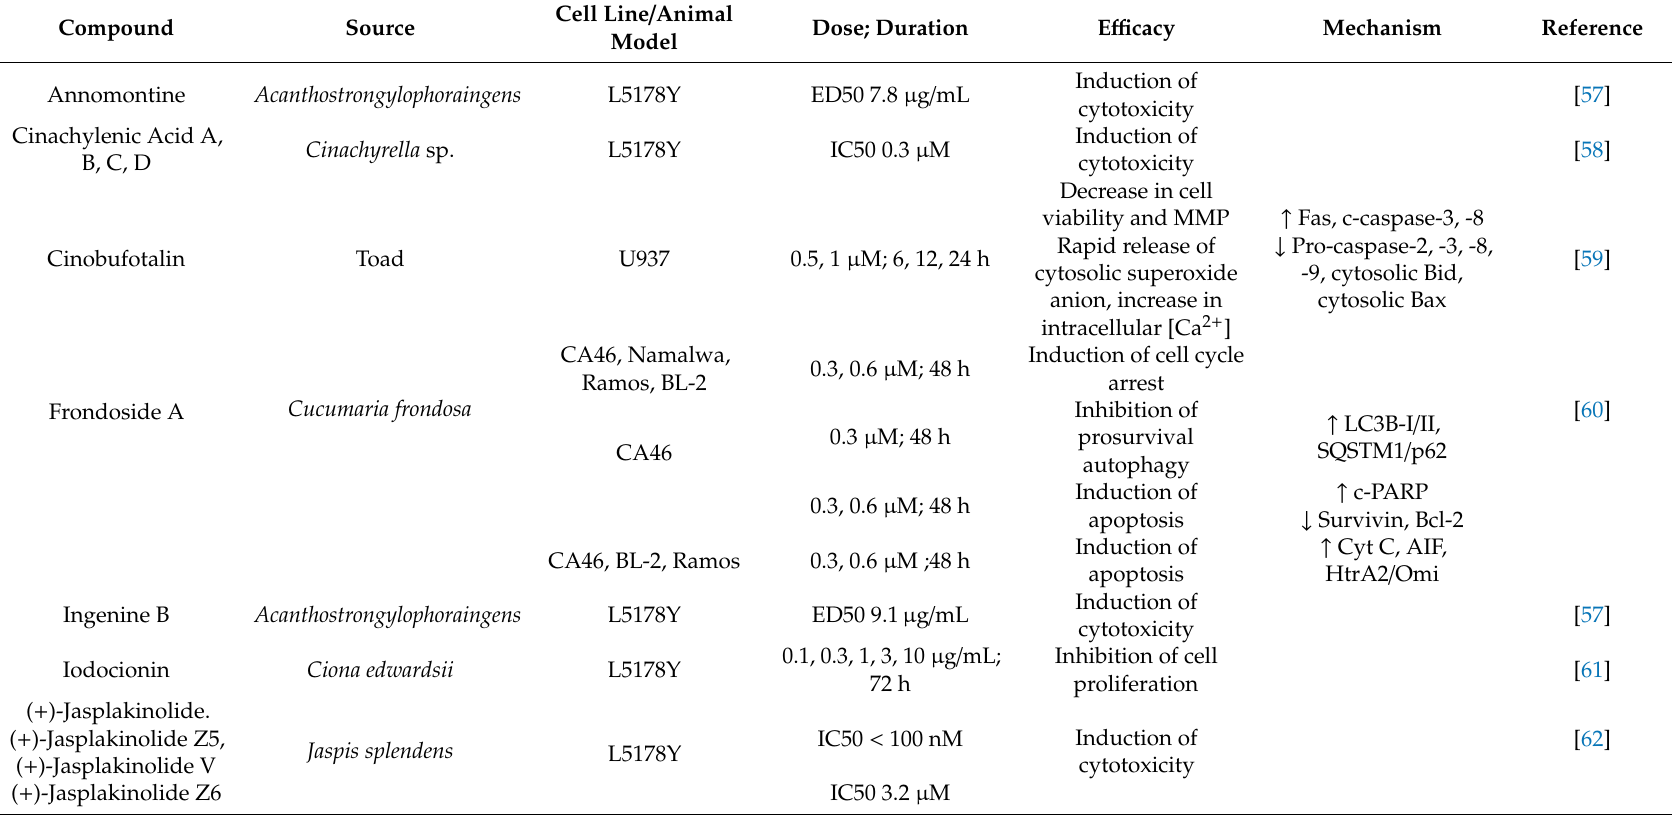
Table 3. Animal-derived compounds and